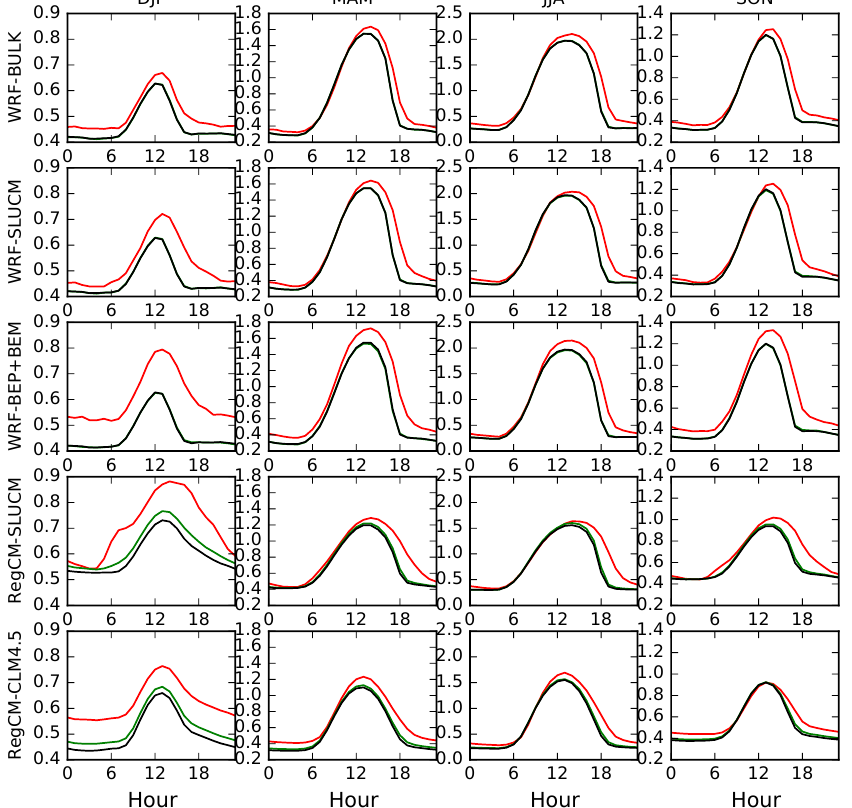
Figure 10. Averaged daily cycles of the PBLH in the Prague city centre (red), in its surroundings (green) and as simulated with the urban surface removed (black) in